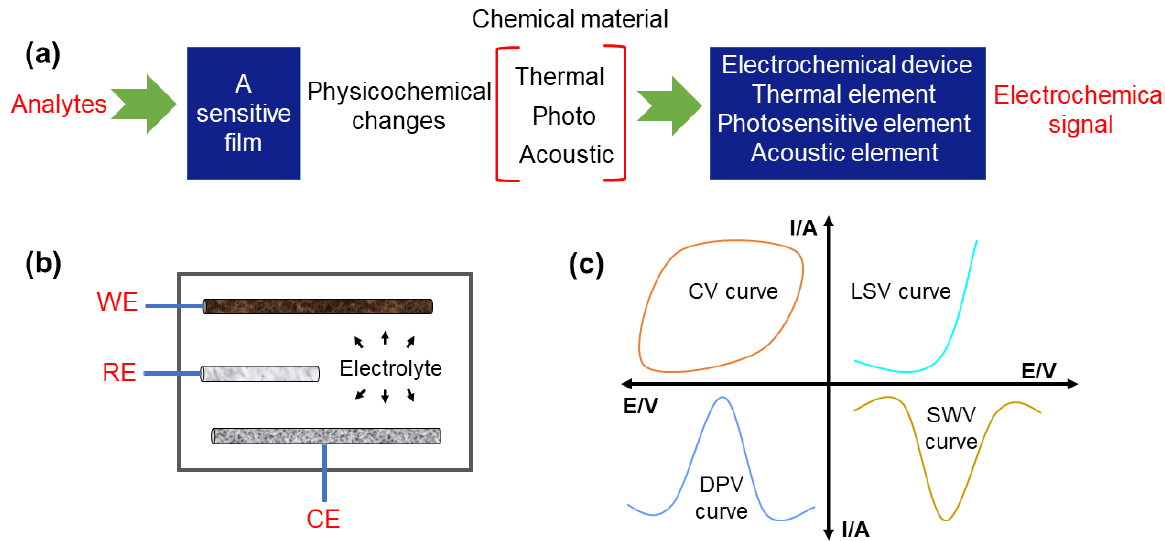
Figure 1. Principle and test methods of electrochemical sensors. ( a ) The detection principle of an electrochemical sensor. ( b ) The basic configuration of an electrochemical sensor. ( c ) The diagrams of cyclic voltammetry (CV), linear sweep voltammetry (LSV), differential pulse voltammetry (DPV), and square wave voltammetry (SWV) curves.